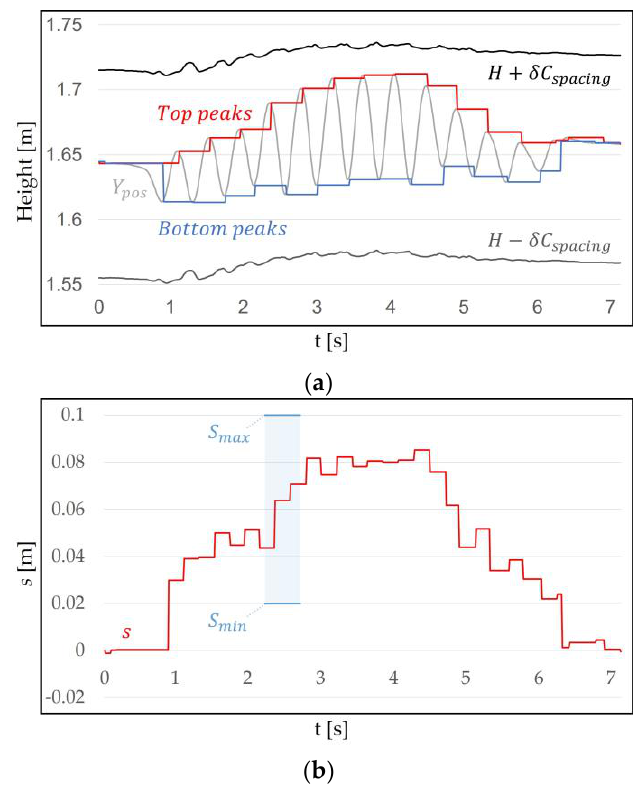
Figure 9. The process of obtaining s by WIP motion: ( a ) The finding of s . The top peak represents the maximum 𝑌 𝑝𝑜𝑠 between two steps, and the bottom peak represents the 𝑌 𝑝𝑜𝑠 when the current step is recognized. ( b ) s , which is the difference between the top peak and the bottom peak. The value of s is located between 𝑆 𝑚𝑖𝑛 and 𝑆 𝑚𝑎𝑥 thresholds ( 𝑠 ∈ [0.02,0.1] ).